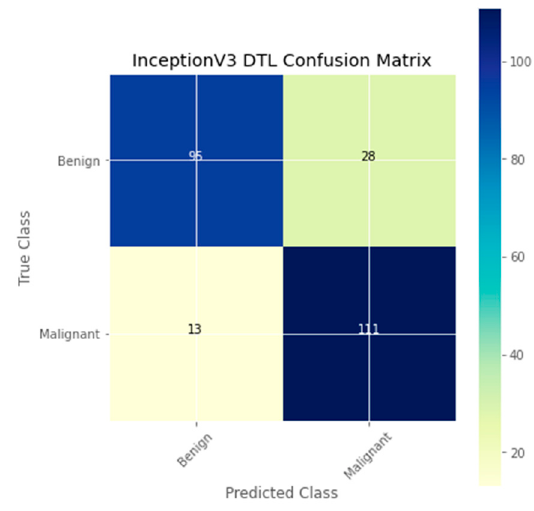
Figure 10. Confusion matrix of the MobileNet model. Figure 10 . Confusion matrix of the MobileNet model. Figure 10 . Confusion matrix of the MobileNet model.